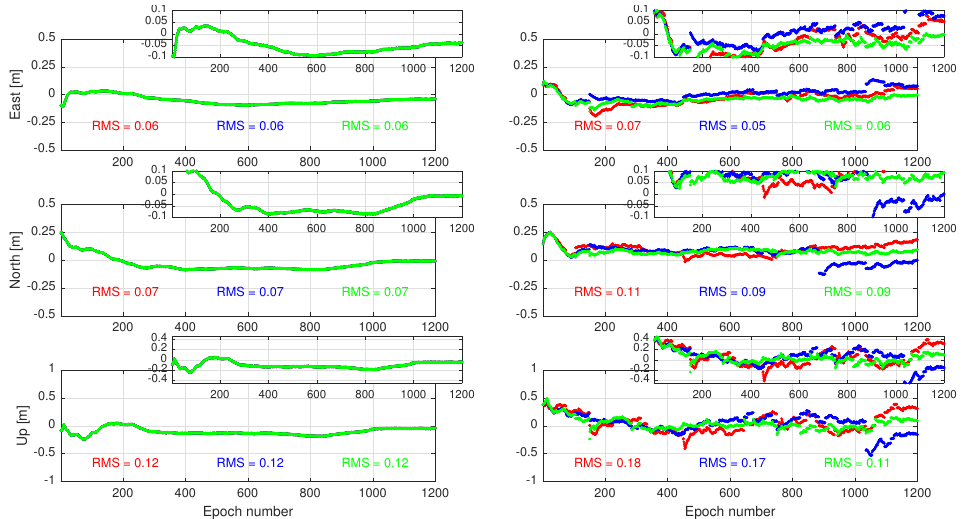
Figure 6. Time-series of the ambiguity-float positioning errors in the East–North–Up directions when the user experiences no correction latency ( left ) and when the correction packs are provided with a time-delay ( right ). The results of Cases 1, 2, and 3 are indicated in red, blue, and green,